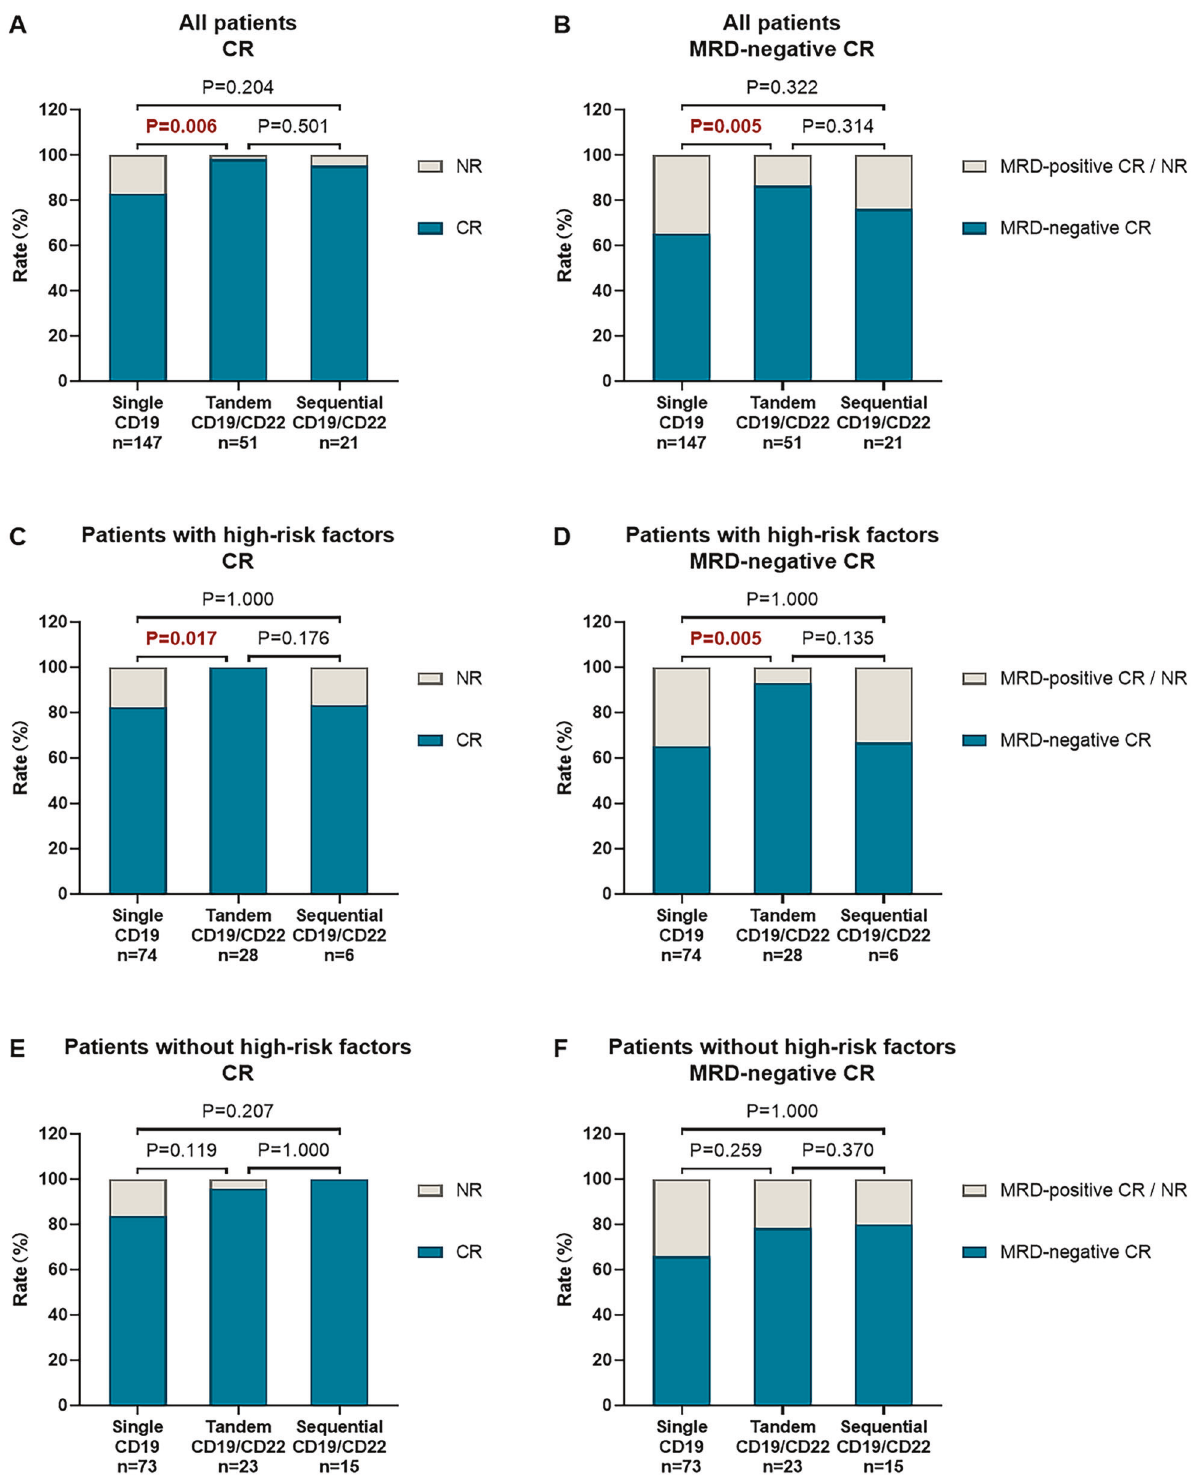
Fig. 2 Response to CAR T-cell therapy. A CR and B MRD-negative CR rate in all patients. C CR and D MRD-negative CR rate in patients with high-risk cytogenetic and genetic characteristics. E CR and F MRD-negative CR rate in patients without high-risk cytogenetic and genetic the single CD19 group, the tandem CD19/CD22 group had an increased CR rate in patients with the following characteristics: no history of allo-HSCT (84.5% vs. 100.0%, P = 0.004), no EMD (88.0% vs. 100.0%, P = 0.013), a high tumor burden (78.2% vs. 100.0%,